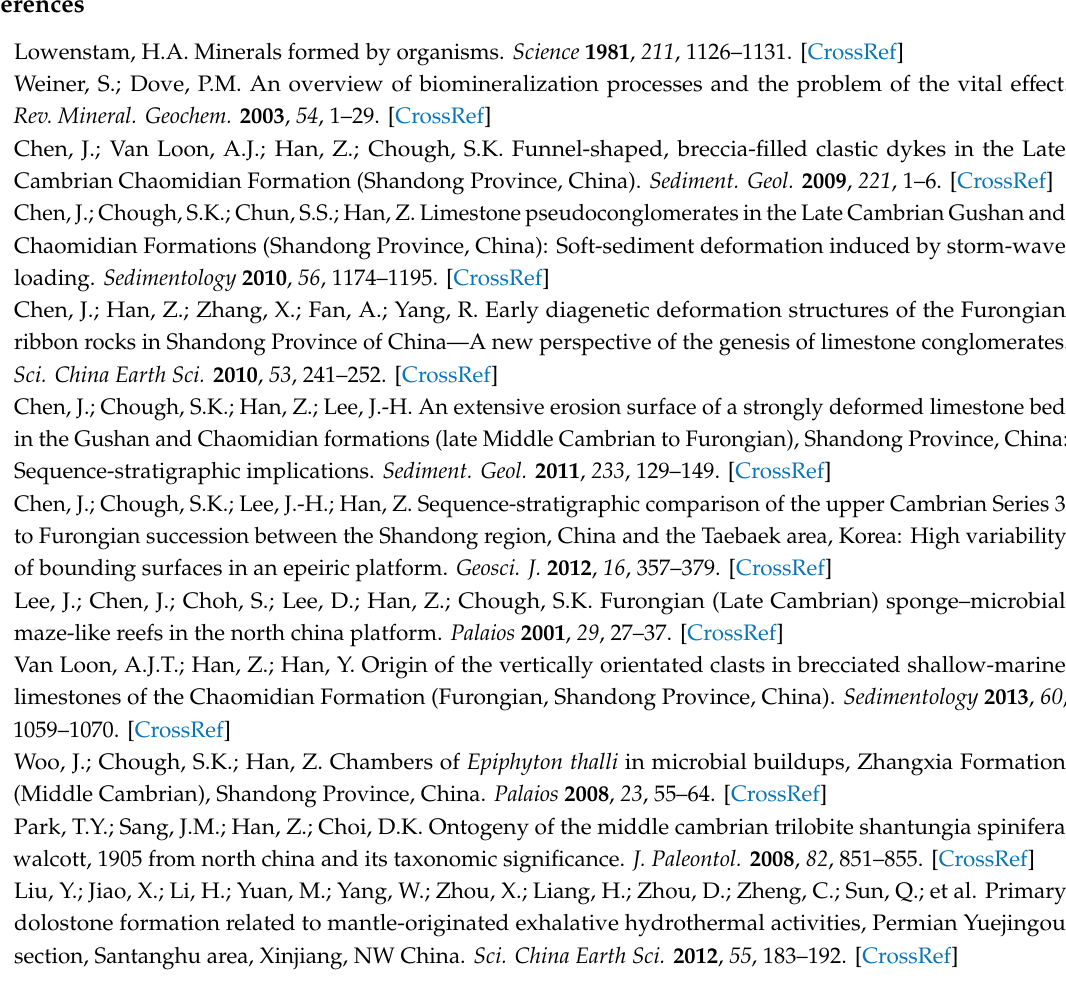
Figure S1: Images of the control groups A and B. (a) The image of control group A, pH was 7.00, and Mg / Ca ratio from left to right was 0,3,6,9, and 12, respectively. (b1) The image of control group B, pH was 9.20, and Mg / Ca ratio from left to right was 0,3,6,9, and 12, respectively. (b2) The image of control group B after centrifugation, pH was 9.20, and Mg / Ca ratio from left to right was 0,3,6,9, and 12, respectively. Figure S2. XRD analysis of the precipitates in the control groups B at pH 9.20 and Mg / Ca ratio of 0. Figure S3. SEM (a, b, c, and d) and EDS (e, f, and g) images of the precipitates in the control groups B at pH 9.20 and Mg / Ca ratio of 0. The elemental analysis of the area marked by the red square in figure a, b, and c was shown in e, f, and g,